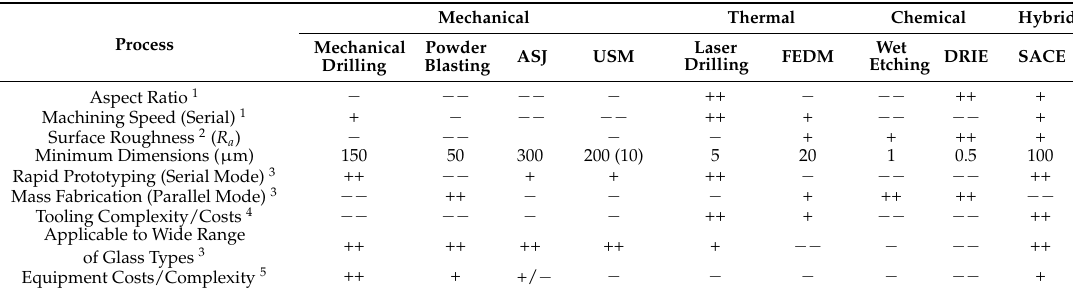
Table 1. Features of the four main groups of drilling technologies for